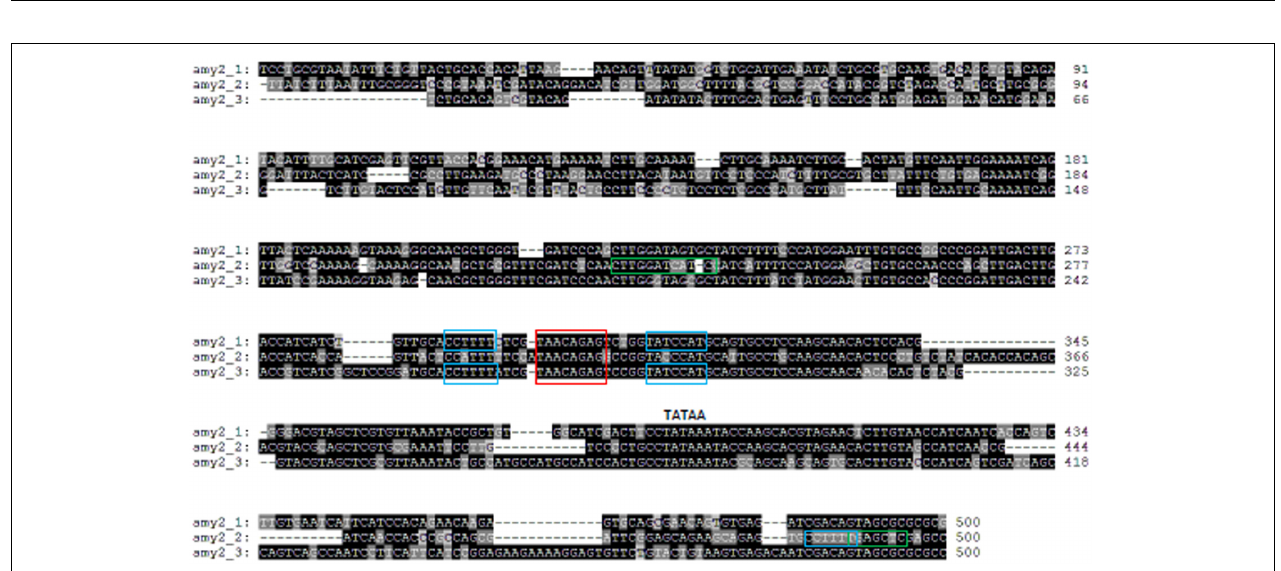
FIGURE 3 | Barley amy2 promoter sequence alignments and conserved motif analysis. All three amy2 promoters contain a GA-responsive element (GARE) TAACAGAG (red box) required for GA induction. Promoters of amy2_1 and amy2_3 contained a pyrimidine box (CCTTTT) and a TATCCA(C/T) box (blue boxes), which enhance gene expression (Gubler and Jacobsen, 1992). A pyrimidine box (blue box), a cAMP-like responsive element (TGAGCTC) (green box) and an O2S (CTTGXXTCATC) (green box) were present on amy2_2 promoter.